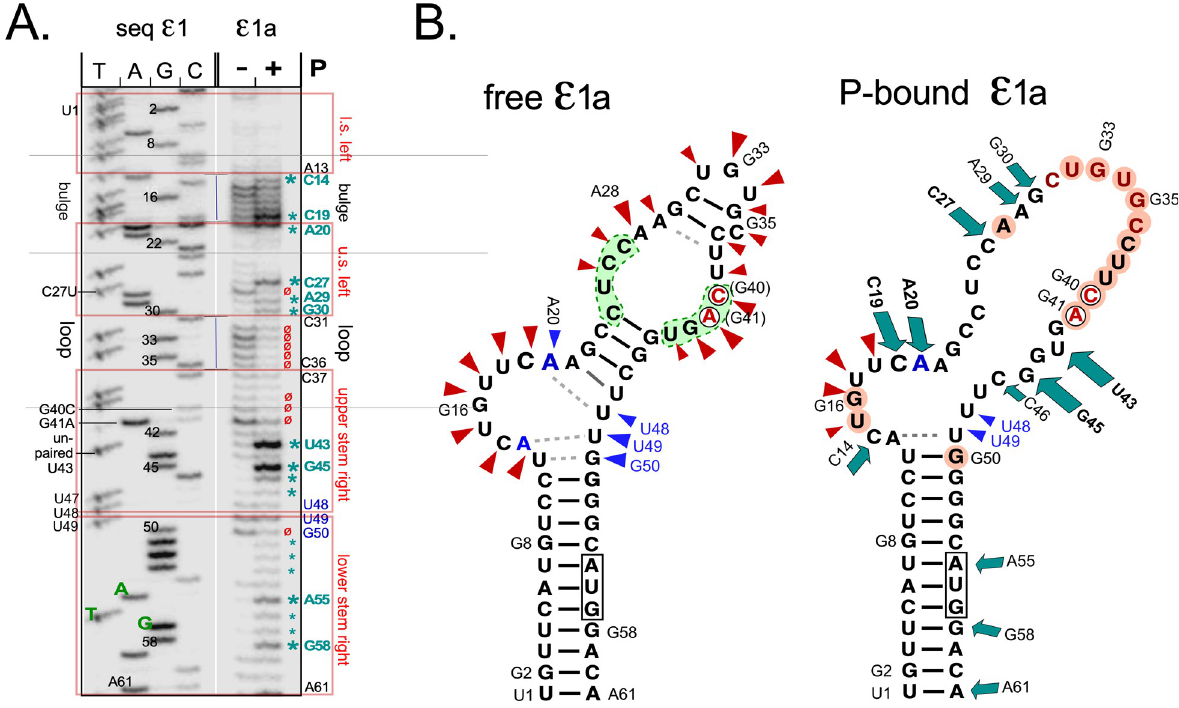
Fig 8. A major conformational shift in ε 1a RNA upon P binding revealed by natively purified immobilized miniP. Biotinylated MBP-HBVminiP-BAP expressed at 12˚C in E . coli Arctic Express cells and present in the soluble fraction of the cell lysate was bound to monomeric avidin beads (S8 Fig), washed and incubated with in vitro transcribed ε 1a RNA. After 1 h at 30˚C, the bead-bound RNA was reacted with NAI and released from the beads by boiling in SDS sample buffer for primer extension as in Fig 5. In parallel, free ε 1a was subjected to SHAPE analysis . (A) Denaturing PAGE analysis of extension products from free versus P-bound ε 1a RNA. Bands with enhanced reactivity in the bound state are indicated by green asterisks, those with reduced reactivity by red ø . (B) SHAPE hits superimposed on secondary structure models of free and P- bound ε 1a RNA. Data for free ε 1a fully reproduced those shown in Fig 5; positions with enhanced NAI accessibility in bound RNA are highlighted by green arrows, positions with lower reactivity than in free RNA by light red background. Slightly enhanced signals in the lower right stem will require further